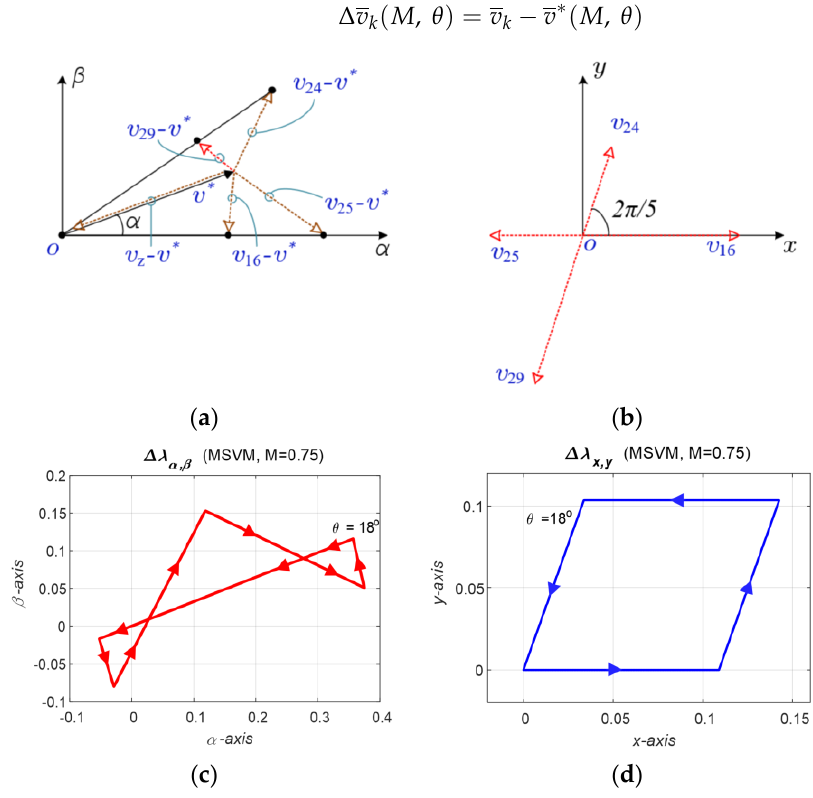
Figure 14. Generation of error voltage vector and harmonic-flux trajectory during the half of the switching cycle of five-phase SSI using MSVM scheme [26]. ( a ) Generated error-voltage vectors in 𝛼𝛽 subspace. ( b ) Generated error-voltage vectors in 𝑥𝑦 subspace. ( c ) Harmonic-flux trajectory for M = 0.75, 𝜃 = 18 𝑜 in 𝛼𝛽 plane. ( d ) Harmonic-flux trajectory for M = 0.75, 𝜃 = 18 𝑜 𝑥𝑦 plane.